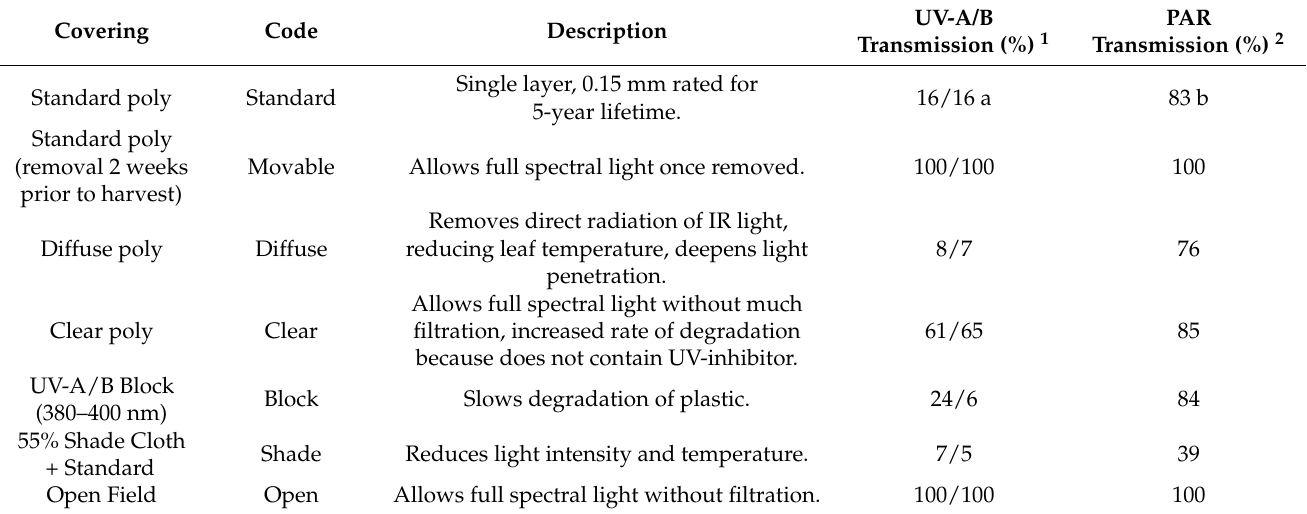
Table 1. Polyethylene (poly) coverings in the high tunnel system, corresponding codes, product descriptions, and ultra-violet (UV) and photosynthetic active radiation (PAR) transmission for the studied lettuce samples.